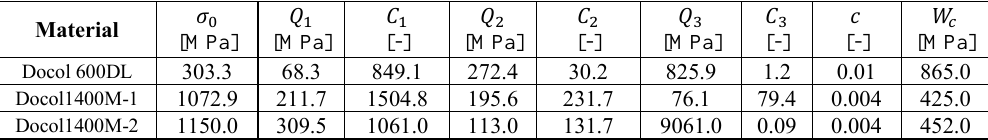
Table 2. The material parameters applied for both materials in this